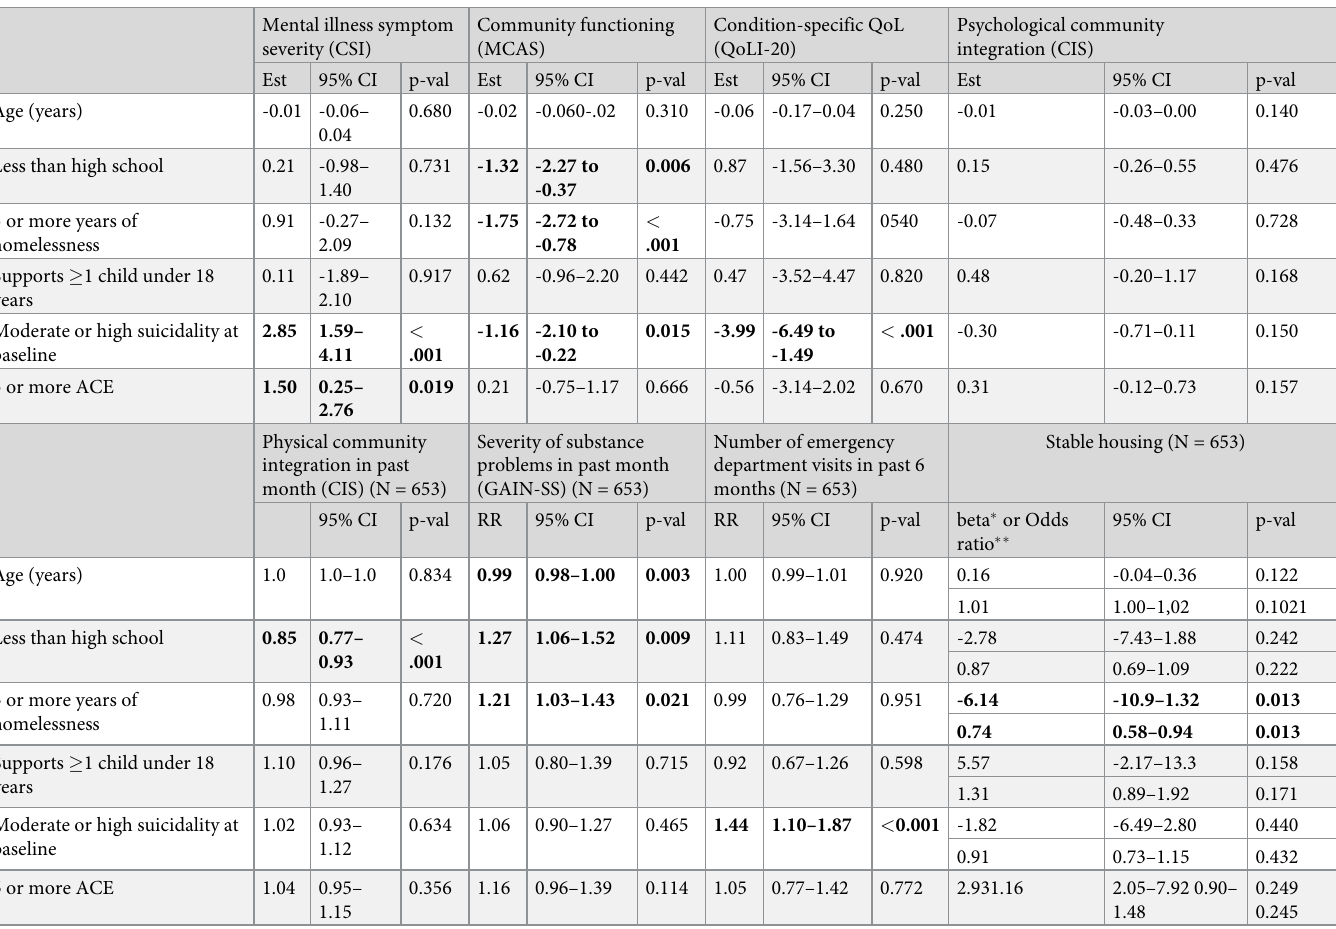
Table 4. Post-imputation pooled coefficient estimates (95% confidence interval) for predictors in linear mixed models for repeated measures for continuous out- comes and rate ratios (95% confidence interval) for generalized estimating equations models for count outcomes for the sample of women in the At Home/Chez Soi study (N =